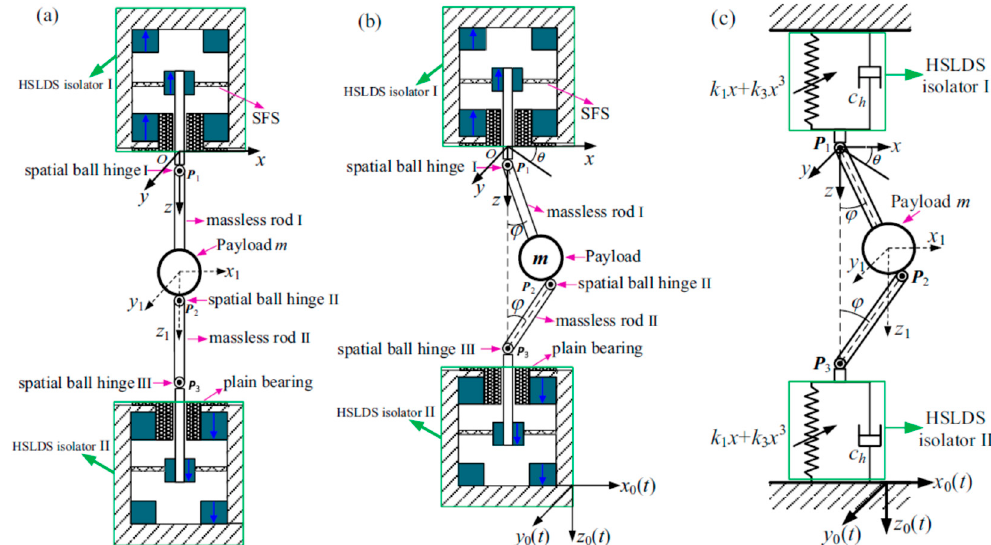
Figure 9. Schematic diagram of the multi-direction vibration isolator ( a ) shows the static equilibrium position; ( b ) shows the base excitations x0(t), y0(t), and z0(t) applied to the isolator; ( c ) shows the equivalent mechanical model of the isolator [62].